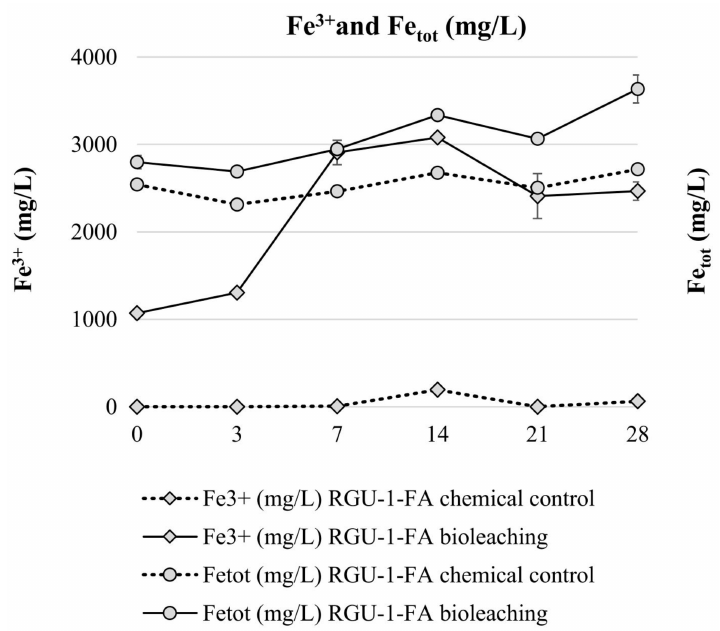
Figure 4. Evolution of Fe 3 + and total Fe concentrations during bioleaching and chemical leaching of RGU-1-FA ore; iron concentrations (mg / L). The x-axis represents the leaching duration (days).